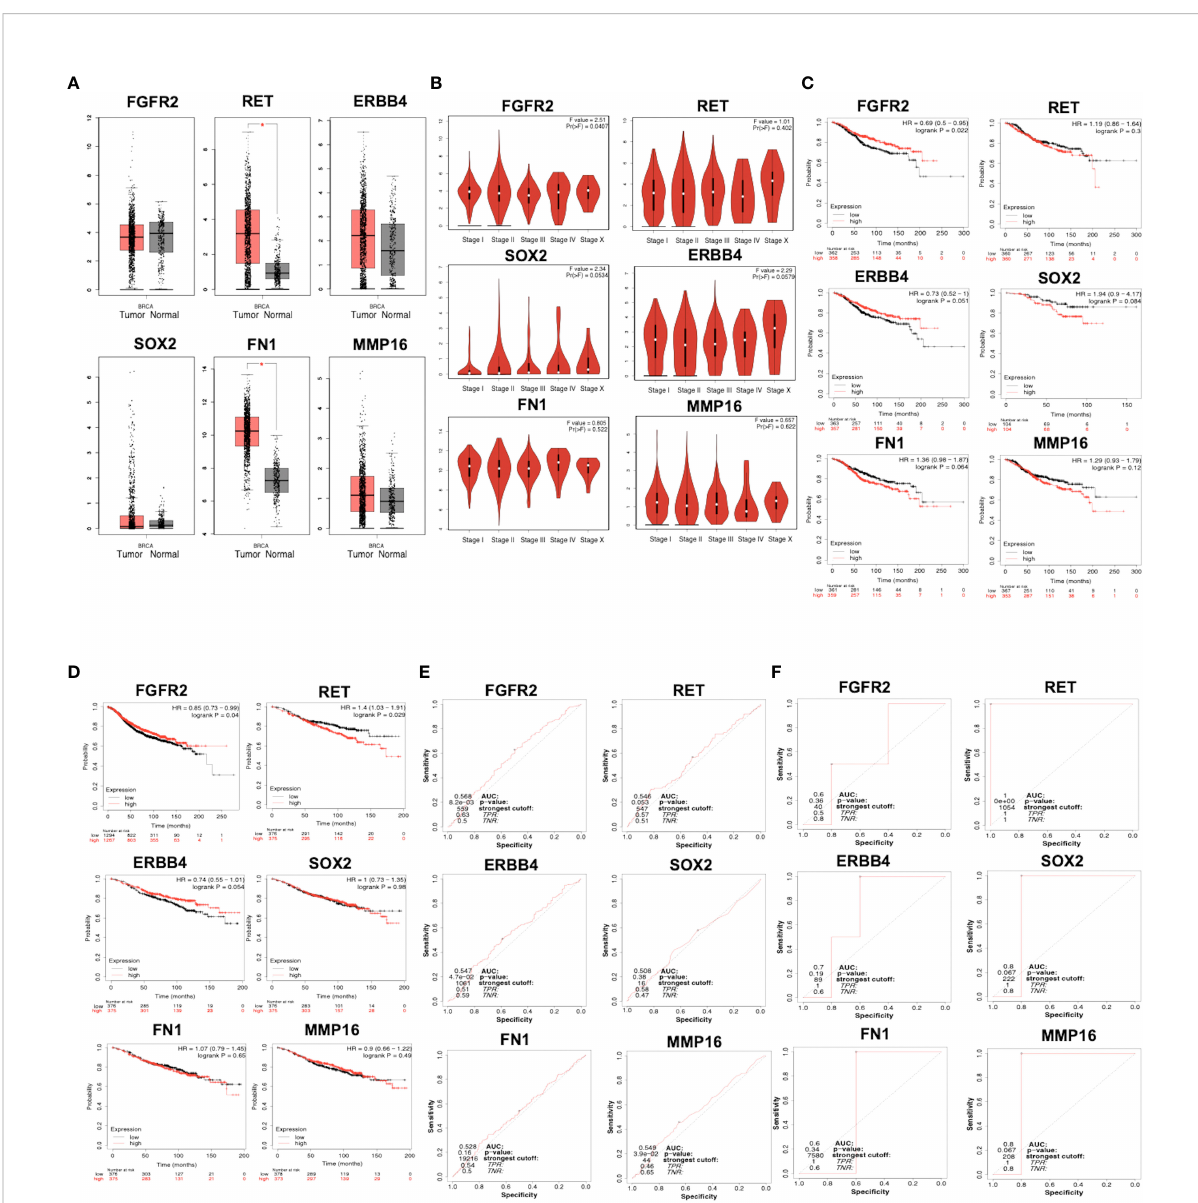
FIGURE 3 (A) mRNA expression of FGFR2 , ERBB4 , RET , FN1 , MMP16 , and SOX2 in normal and breast cancer tissues, as analyzed by GEPIA. Breast tumor samples = 1085; normal tissues samples = 291. p < 0.01 was selected as a signi fi cant value. (B) The relationship between mRNA level and tumor stages in patients with breast cancer, as analyzed by GEPIA. p < 0.01 was selected as a signi fi cant value. (C) Overall survival related to the expression of FGFR2 , ERBB4 , RET , FN1 , MMP16 , and SOX2 , as analyzed by KMPlotter. (D) Relapse-free survival related to the expression of FGFR2 , ERBB4 , RET , FN1 , MMP16 , and SOX2 , as analyzed by KMPlotter. The ROC plotter of the correlation between FGFR2, ERBB4 , RET , FN1 , MMP16 , and SOX2 expression and TAM sensitivity, as analyzed by relapse-free survival (E) and pathological complete response (F)